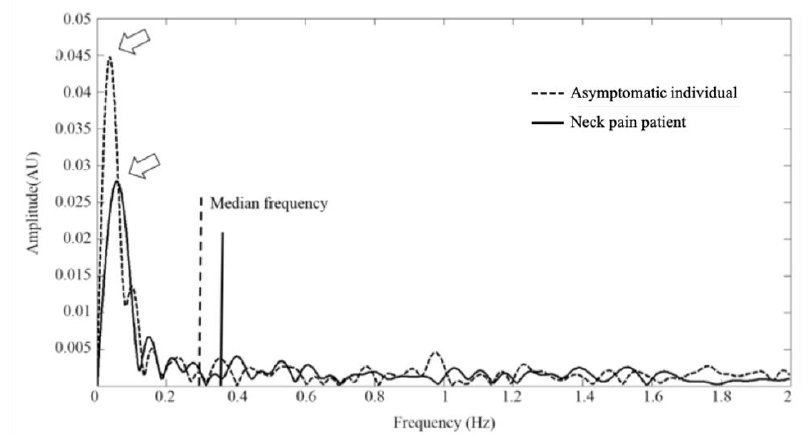
Figure 4. Comparison of the frequency spectrum of muscular oxygenation oscillations from one patient with nonspecific neck pain and asymptomatic individual. Arrowheads and vertical lines represent the lower-frequency distinctive peak at less 0.1 Hz and median frequency of muscle oxygenation oscillation from one patient with nonspecific neck pain and asymptomatic individual, respectively.